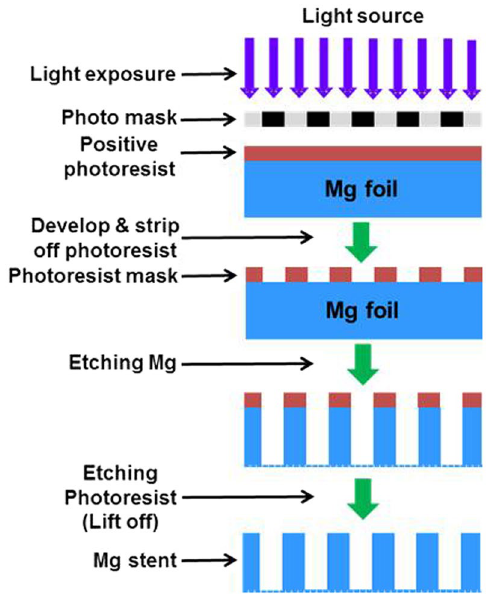
Figure 1. Schematic illustrating the manufacturing steps in the photo-chemical etching approach for making Mg helical